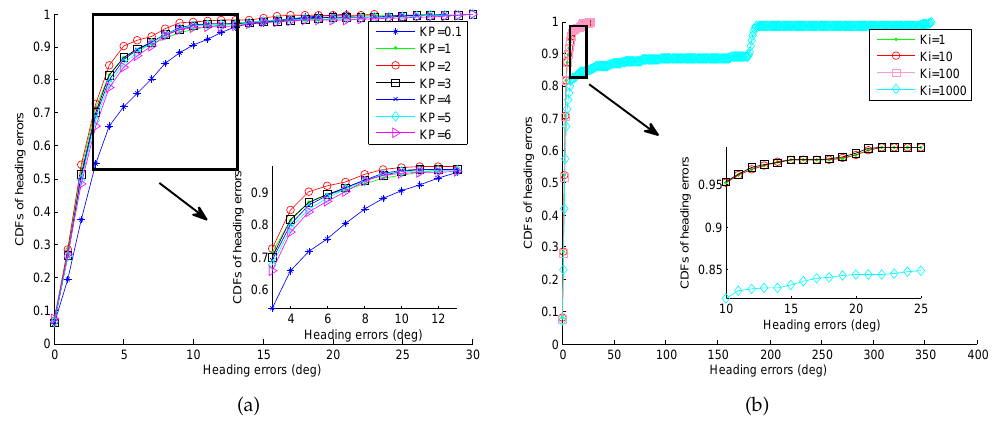
Figure 17. CDFs of errors of heading estimation under different values Kp and Ki . ( a ) Different value Kp ; ( b ) Different value Ki